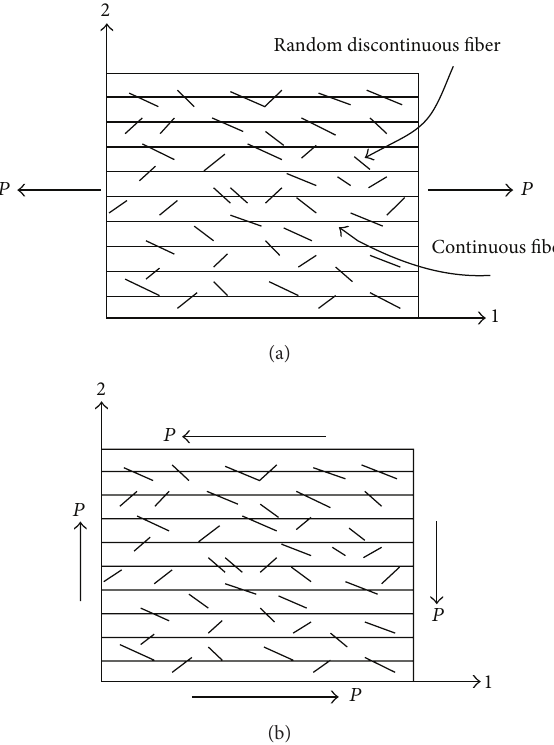
Figure 9: Unidirectional continuous fiber (0 ∘ )